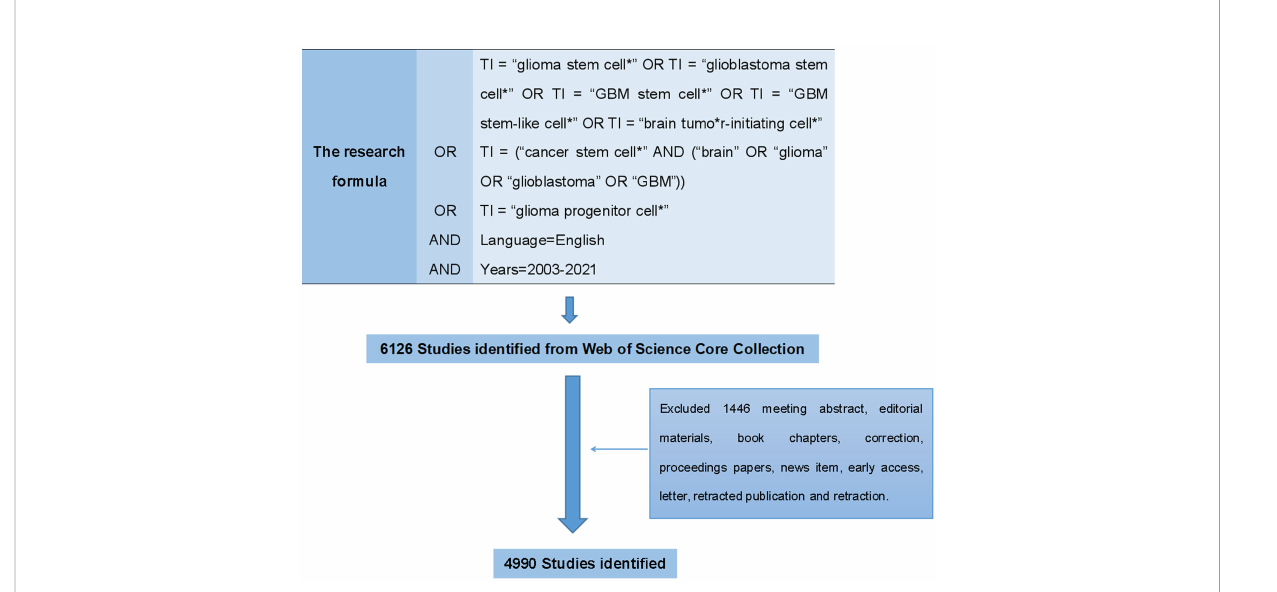
FIGURE 2 The fl owchart of data collection about GSCs on